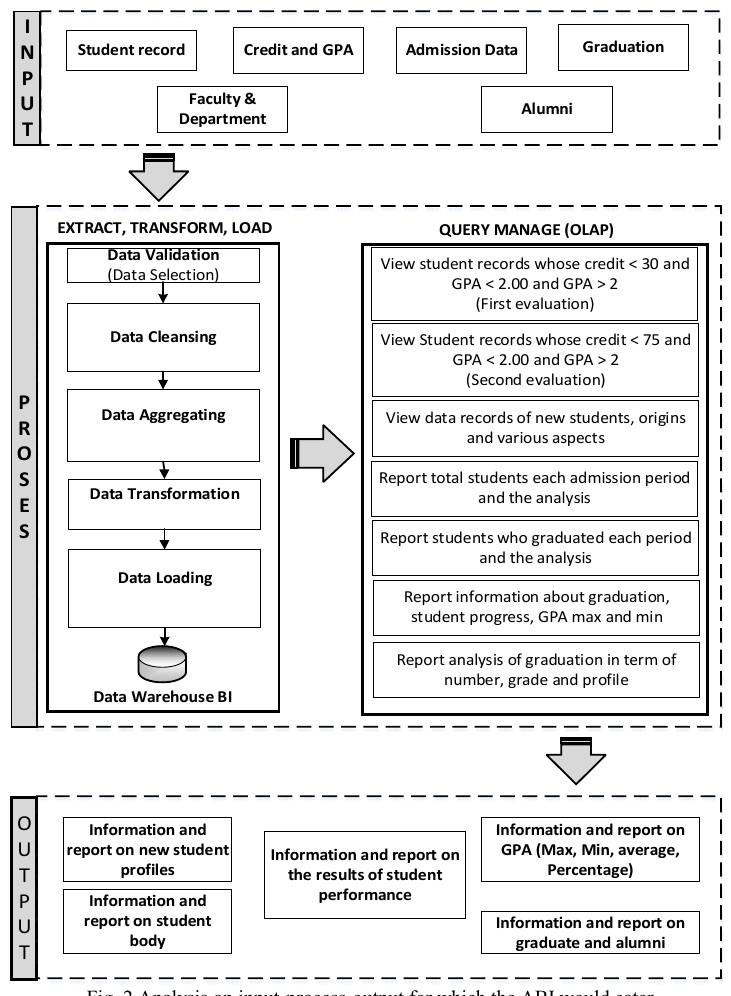
Fig. 2 Analysis on input-process-output for which the ABI would